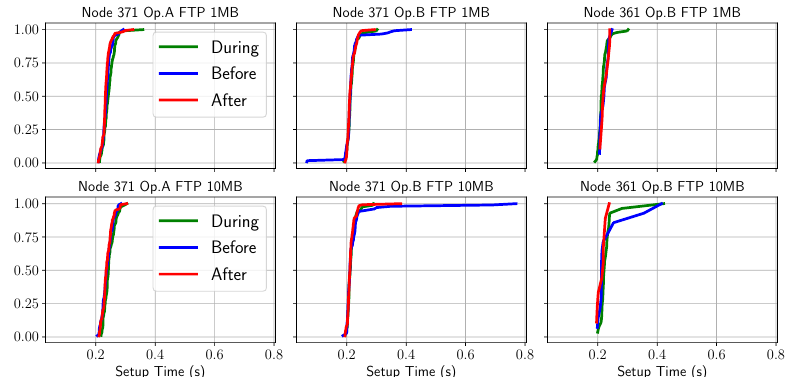
Figure 4. CDF of FTP setup time behavior before/during/after the match.